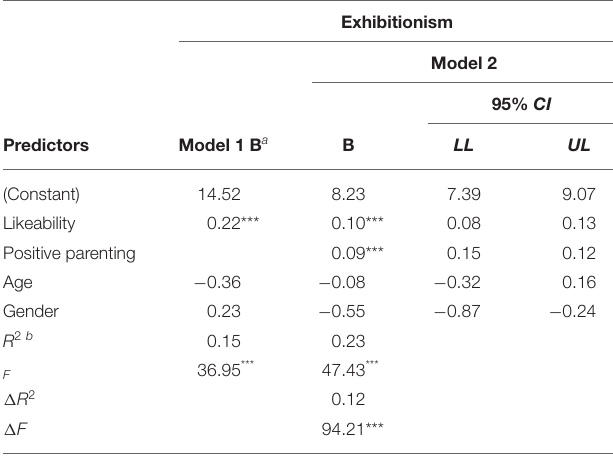
TABLE 10 | Mediating effect of positive parenting (perceived) between likeability (self-concept) and exhibitionism (narcissism) ( N =